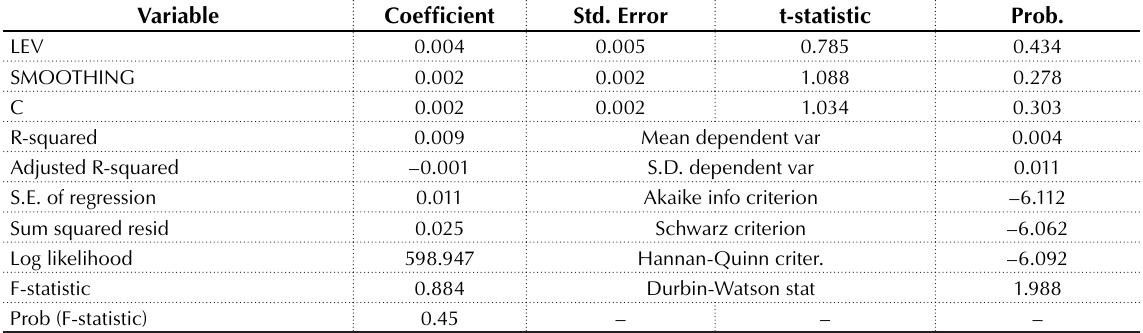
Table 2. Regression analysis for research model